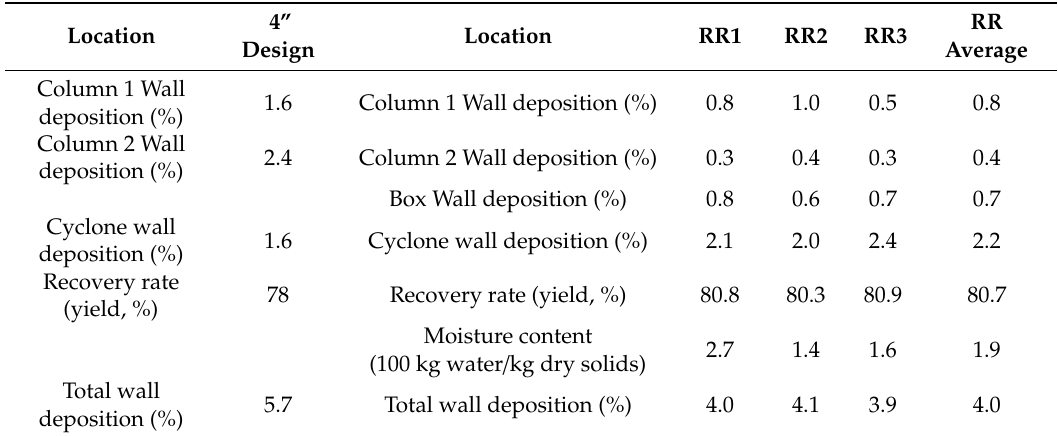
Table 7. Wall deposition percentages for repeated experimental runs at 8.8 wt% solids concentration and an inlet air temperature of 170 ◦ C (RR1 = run 1, RR2 = run 2, RR3 = run 3). The standard error for the deposition percentages was 0.19%.